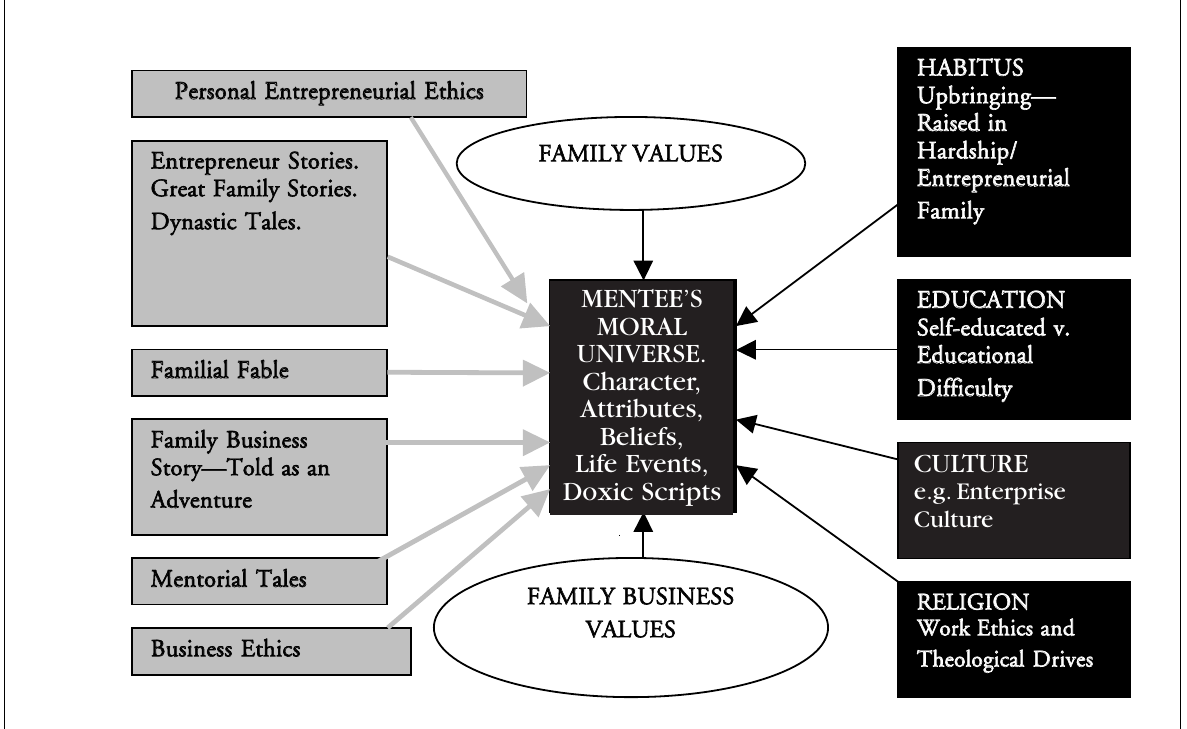
Figure 2. A Self-Perpetuating Virtuous Circle of Morality within Family